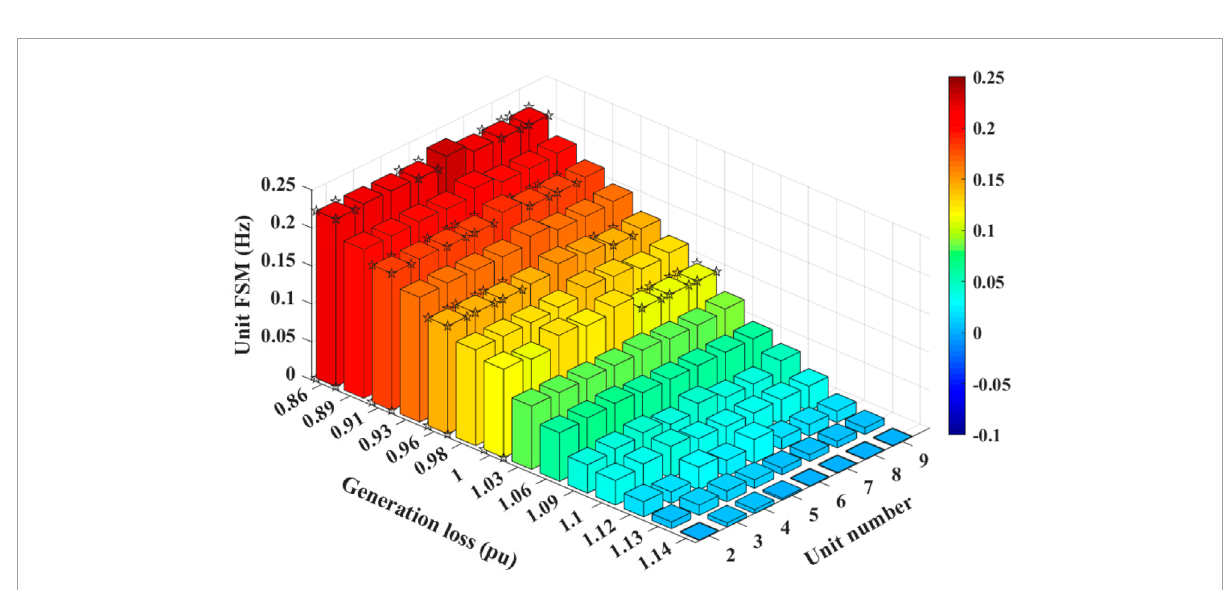
FIGURE 10 Unit frequency stability margin with a 10 MW/10 MWh BESS providing frequency support.